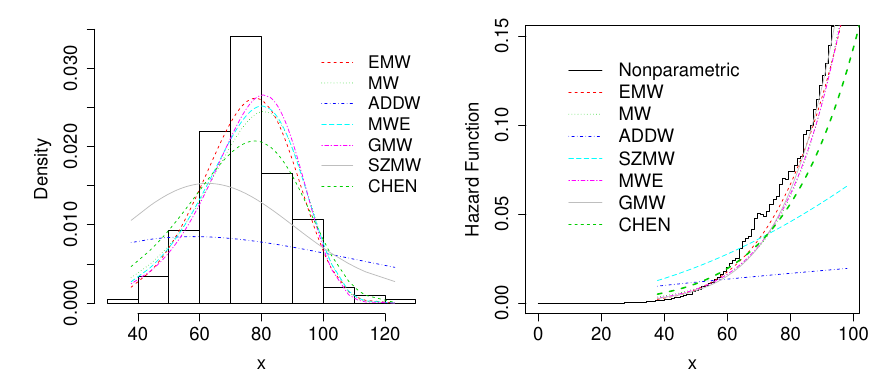
(a) The plots of density function. (b) The plots of hazard rate function.